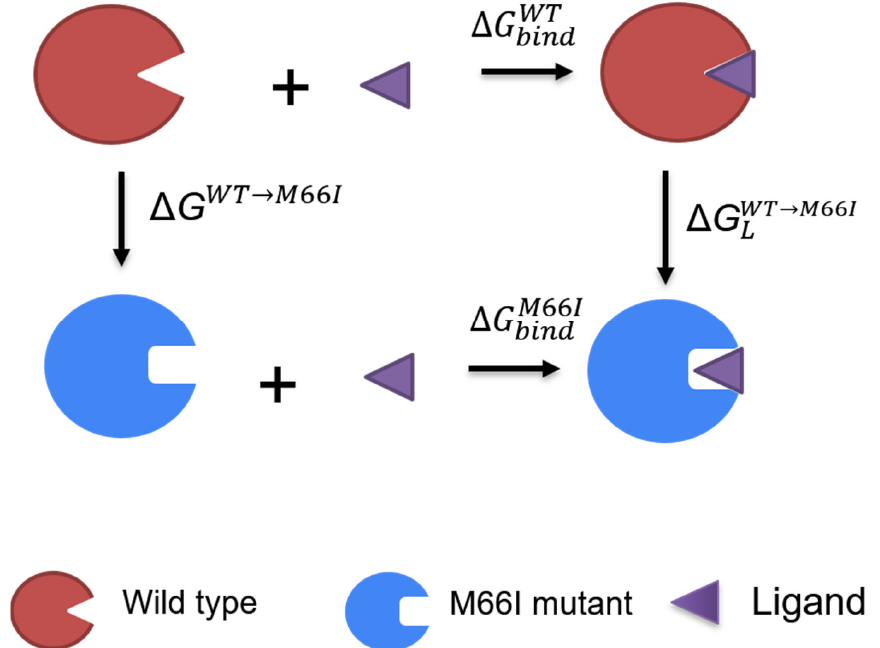
Figure 2. The thermodynamic cycle used for computing the changes in the binding free energy caused by the M66I mutation in the binding of the ligand to the CA dimer.